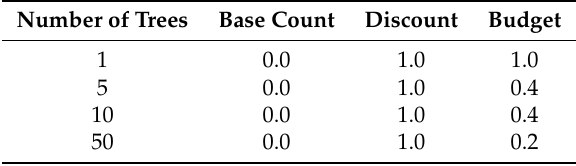
Table 1. Hyperparameters used for the Mondrian